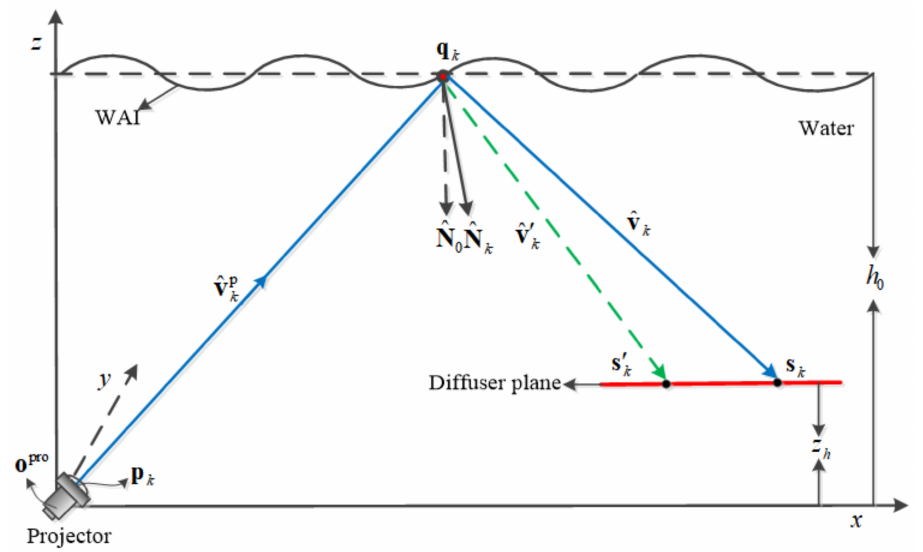
Figure 6. The principle of sampling of WAI